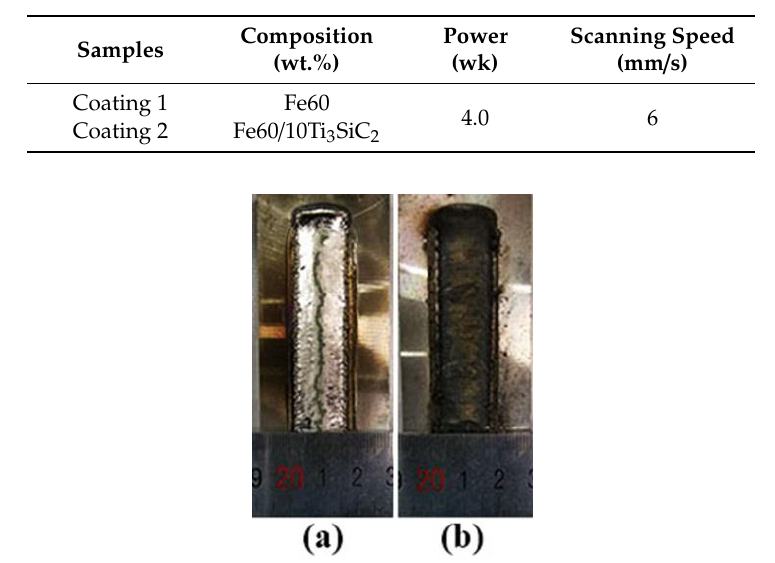
Figure 2. Surface morphologies of laser clad coatings: ( a ) Fe60; ( b ) Fe60/10 wt.%Ti 3 SiC 2 .